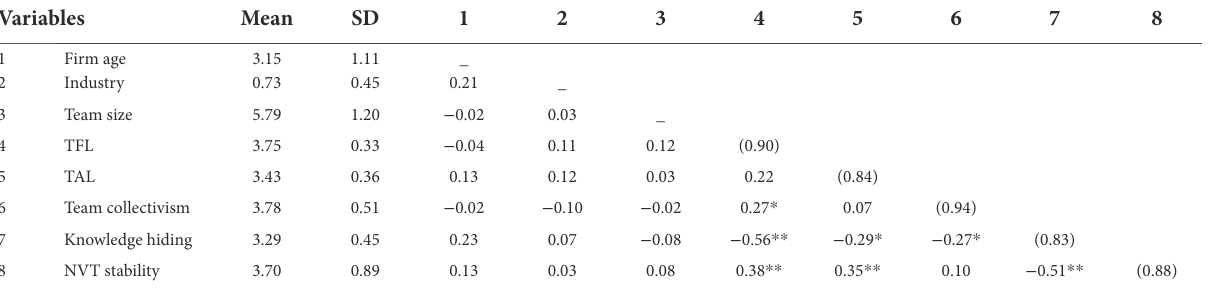
TABLE 2 Means, standard deviations, correlations, and reliability